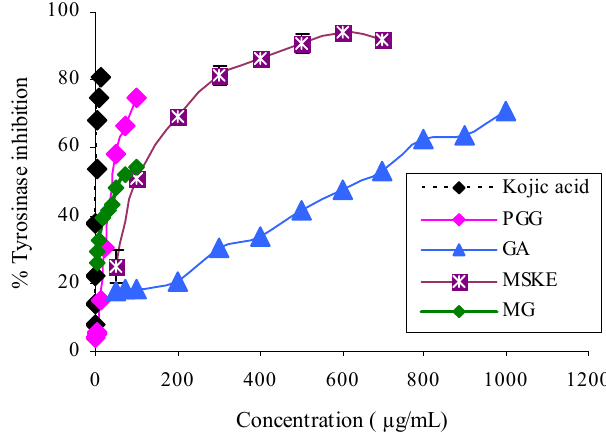
Figure 1. Dose-dependent inhibition of mushroom tyrosinase by MSKE, GA, MG, PGG and the positive reference (KA). Tyrosinase activity was measured using L-DOPA as the substrate. Each value represents mean ± SEM (n = 2).